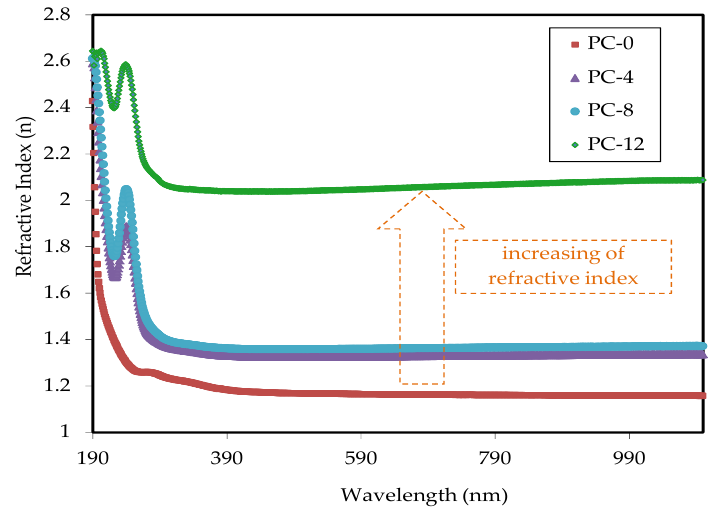
Figure 13. n variation as a function of wavelength.